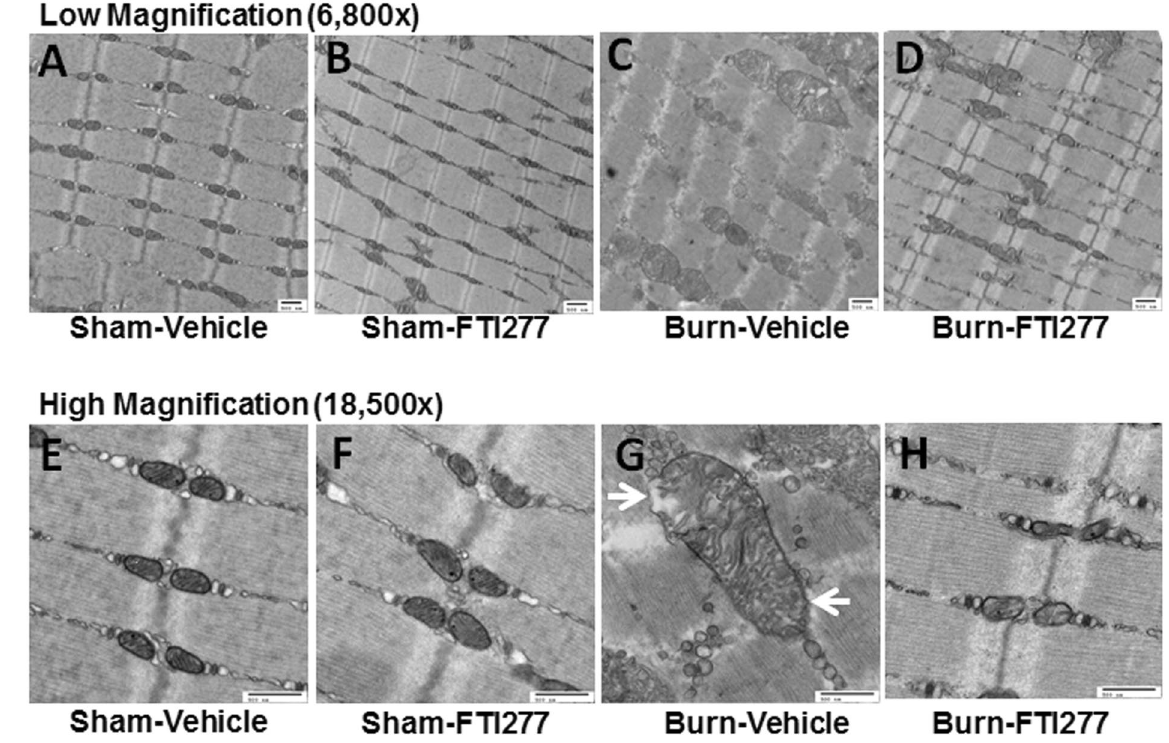
Figure 6. FTI-277 prevented burn-induced mitochondrial morphological changes in skeletal muscle. Enlarged mitochondria were observed in skeletal muscle at 3 days after burn injury, although enlarged mitochondria were not found in sham-burned mice. In addition, burn injury resulted in loss of cristae structure in some area of the mitochondria compared with sham-burn. FTI-277 prevented these morphological alterations induced by burn injury. On the other hand, FTI-277 did not affect the mitochondrial morphology in sham-burned mice ( I – K ). Arrows indicate the area with loss of cristae structure ( G ). ( A – D ): low magnification (6,800x), ( E – H ): high magnification (18,500x). scale bar: 500 nm. ( A , E ): sham-vehicle. ( B , F ): sham-FTI. ( C , G ): burn-vehicle. ( D , H ):